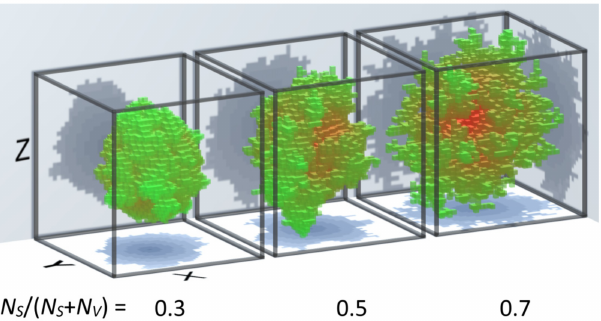
Figure 1. Geometry of systems obtained based on the diffusion limited aggregation (DLA) algorithm with different ratio of the number of particles on the surface ( N S ) to the volume ( N V